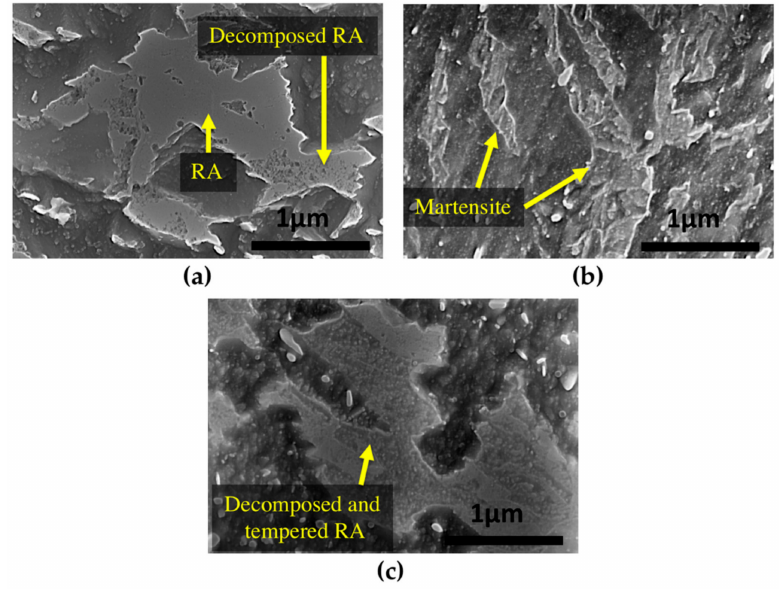
Figure 6. SEM images of ( a ) blocks of partially decomposed retained austenite after 16 h of tempering at 350 ◦ C; ( b ) fresh martensite formed during cooling after 16 h of tempering at 550 ◦ C and ( c ) fully decomposed retained austenite and tempered microstructure blocks after 16 h of tempering at 600 ◦